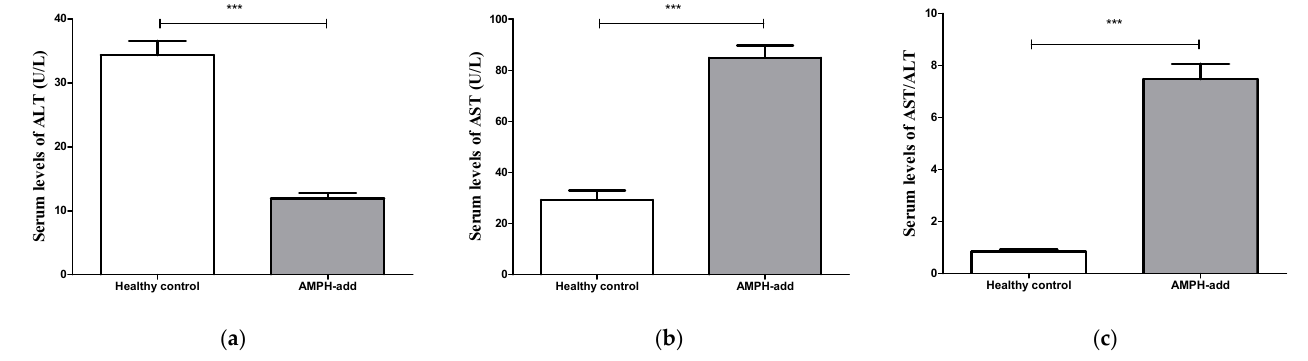
Figure 4. Comparison of ALT ( a ), AST ( b ) and AST/ALT ratio ( c ) serum level AMPH-adds and control. Data are expressed as mean ± standard error. Statistical analysis was carried out using unpaired Student’s t -test. ***: statistically significant at p < 0.001.